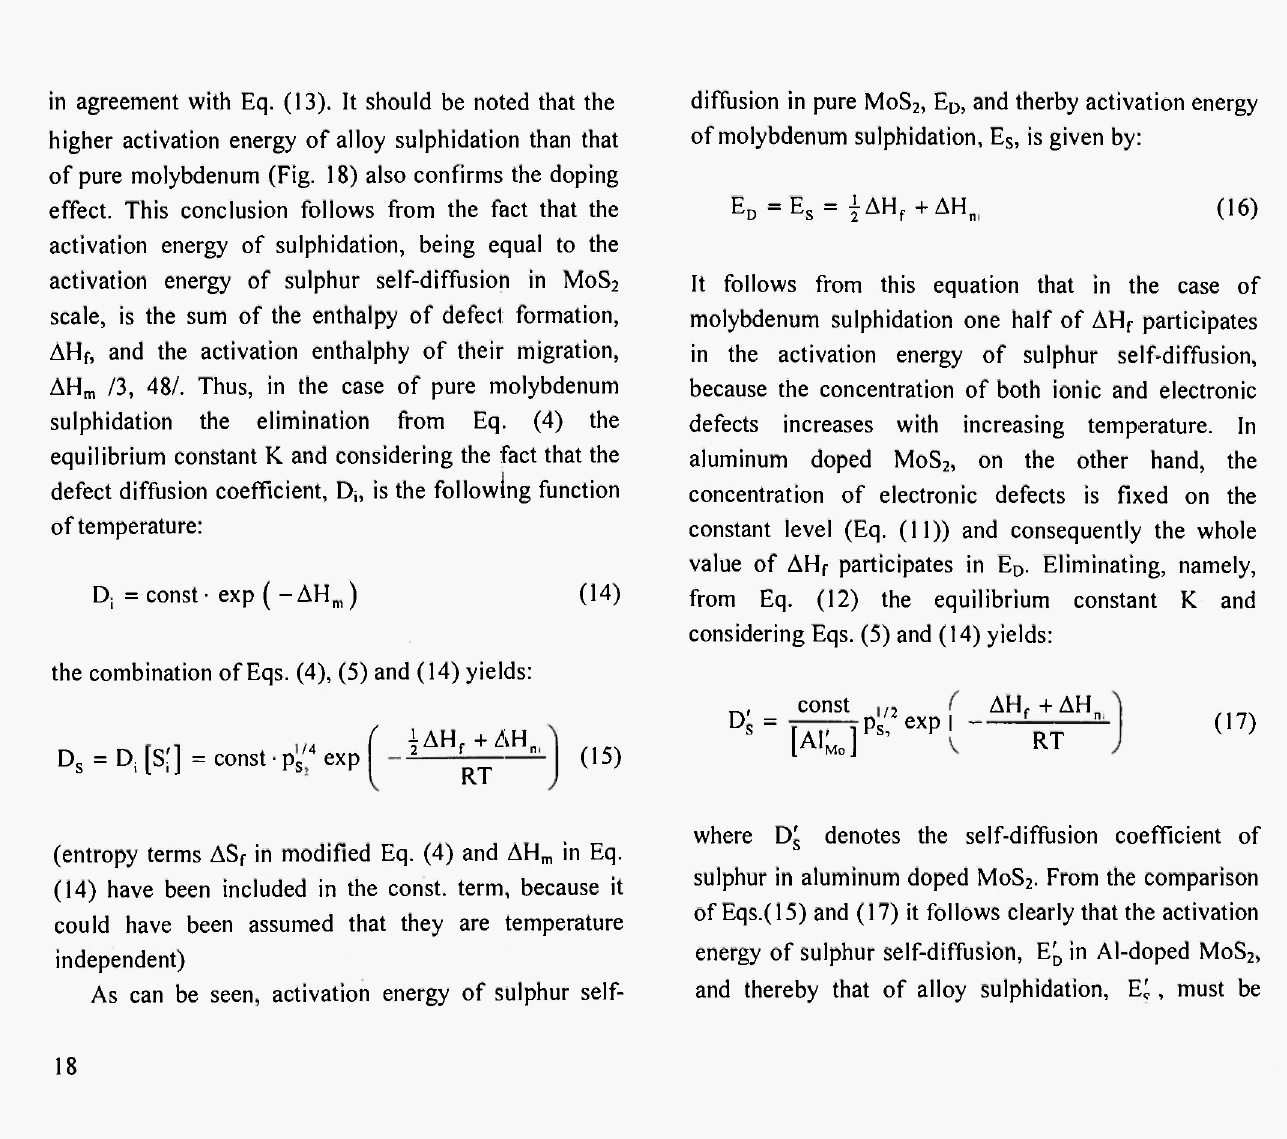
Fig. 23: The dependence of the sulphidation rate of Al-34Mo alloy and pure molybdenum on sulphur pressure at 1173